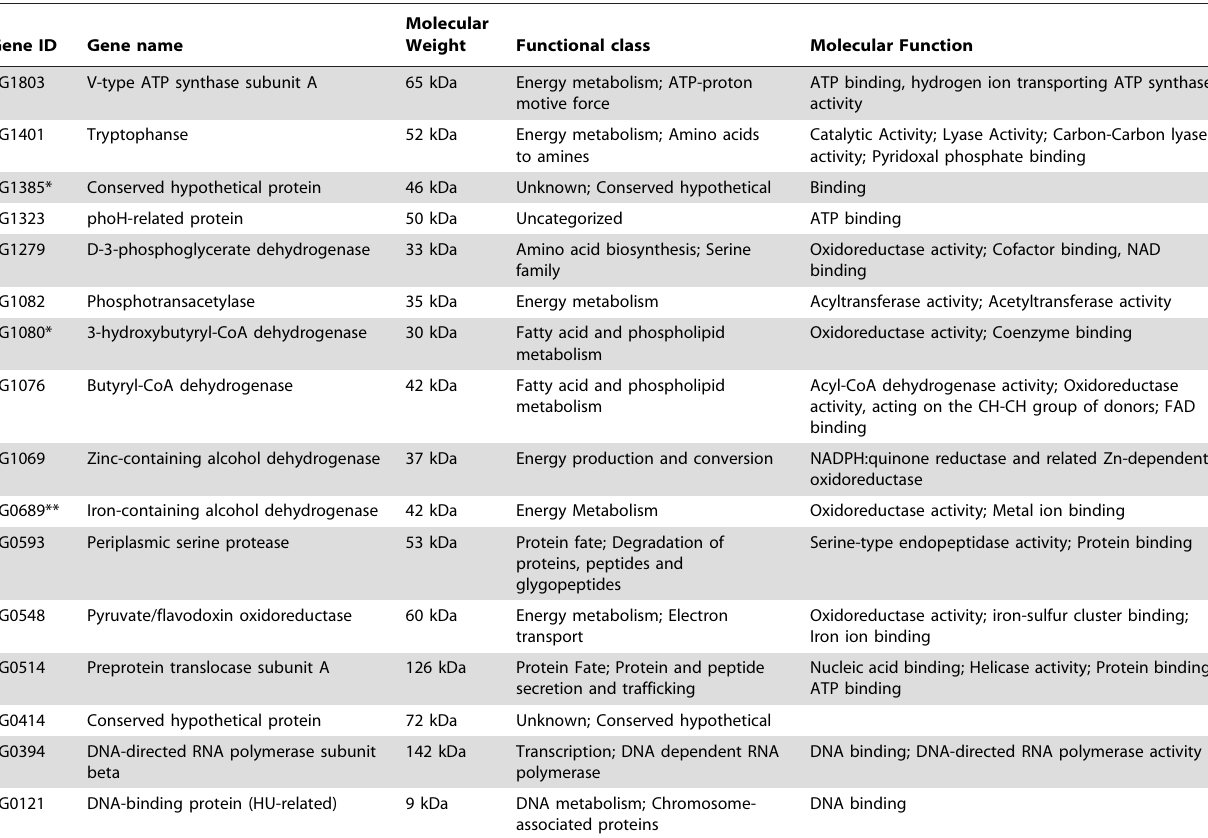
Table 4. Proteins that interact with recombinant